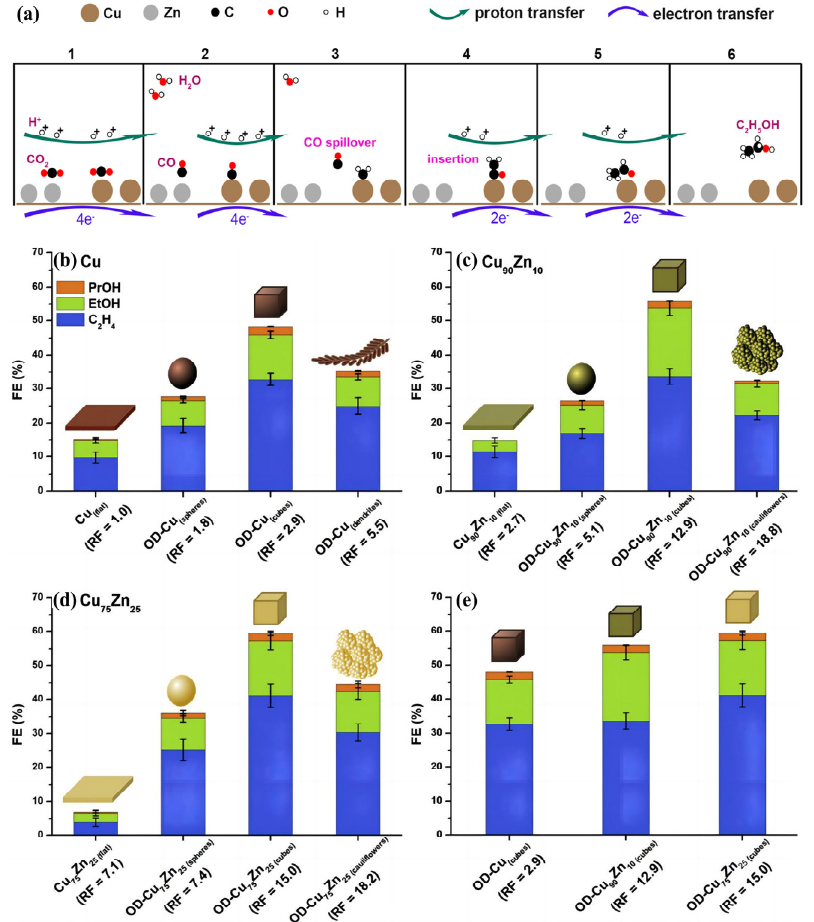
Figure 8. ( a ) Proposed mechanism for the electroreduction of CO 2 to ethanol on Cu x Zn catalysts: stage 1 → 2, reduce CO 2 to CO on Cu and Zn, respectively (2CO 2 + 4H + + 4e − → 2CO + 2H 2 O); stage 2 → 3, reduce CO molecule to *CH 2 on Cu (CO + 4H + + 4e − → *CH 2 + H 2 O ); stage 3 → 4, CO insert into the bond between the Cu surface and *CH 2 , to form *COCH 2 (CO + *CH 2 → *COCH 2 ); stage 4 → 5, reduce *COCH 2 to CH 3 CHO (*COCH 2 + 2H + +2e − → CH 3 CHO); stage 5 → 6, reduce CH 3 CHO to CH 3 CH 2 OH (CH 3 CHO + 2H + +2e − → CH 3 CH 2 OH) [123]. Reprinted with permission from Ref. [124]. Copyright © 2023, American Chemical Society. ( b ) FE on Cu(flat), OD-Cu(spheres), OD-Cu(cubes), and OD-Cu(dendrites), ( c ) FE on Cu 90 Zn 10 (flat), OD-Cu 90 Zn 10 (spheres), OD-Cu 90 Zn 10 (cubes), and OD-Cu 90 Zn 10 (cauliflowers), ( d ) FE on Cu 75 Zn 25 (flat), OD-Cu 75 Zn 25 (spheres), OD-Cu 75 Zn 25 (cubes), and OD-Cu 75 Zn 25 (cauliflowers), and ( e ) OD-Cu(cubes), OD-Cu 90 Zn 10 (cubes), and OD-Cu 75 Zn 25 (cubes) at − 1.1 V vs. RHE [113].